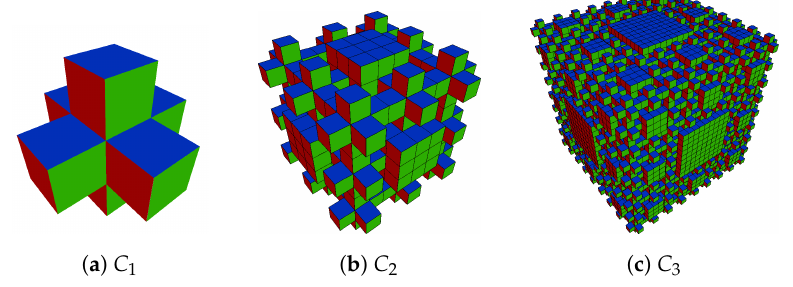
Figure 9. First three levels of the complement of the Menger sponge fractal.